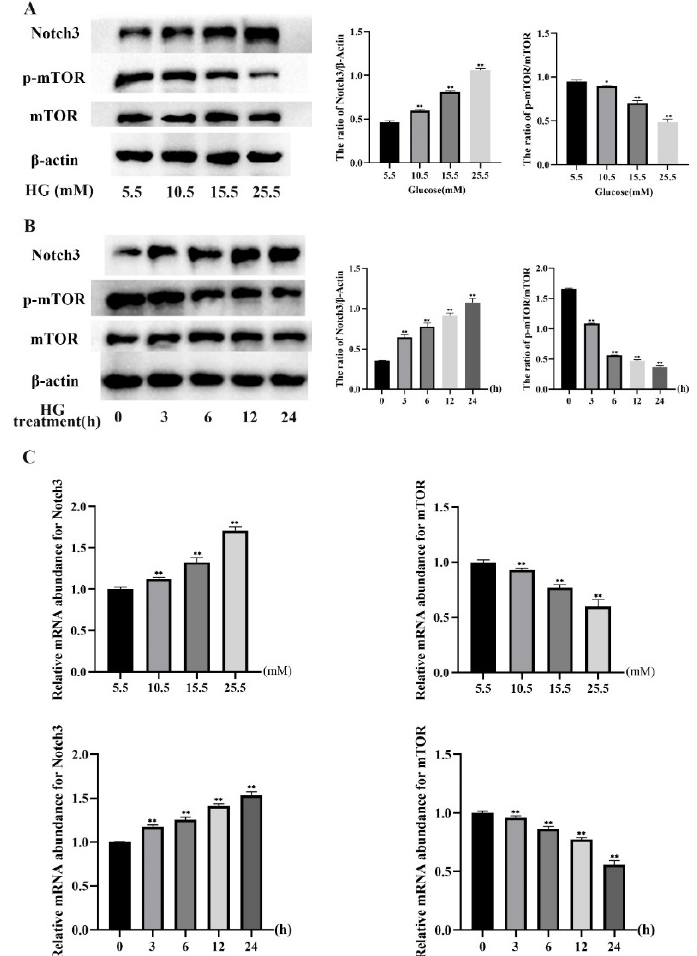
Figure 5. HG induced Notch3 and mTOR signaling pathways in MDBK cells. MDBK cells were treated with 5.5, 10.5, 15.5, and 25.5 mM glucose for 24 h, respectively; MDBK cells were treated with 25.5 mM glucose for 0, 3, 6, 12, and 24 h, respectively. Western blot, and qRT-PCR were used to assess protein expression, and gene expression, respectively. ( A , B ) The protein level of Notch3, mTOR, and p-mTOR; ( C ) The mRNA expression level of Notch3 and mTOR. * p < 0.05 and ** p < 0.01 compared with control group.